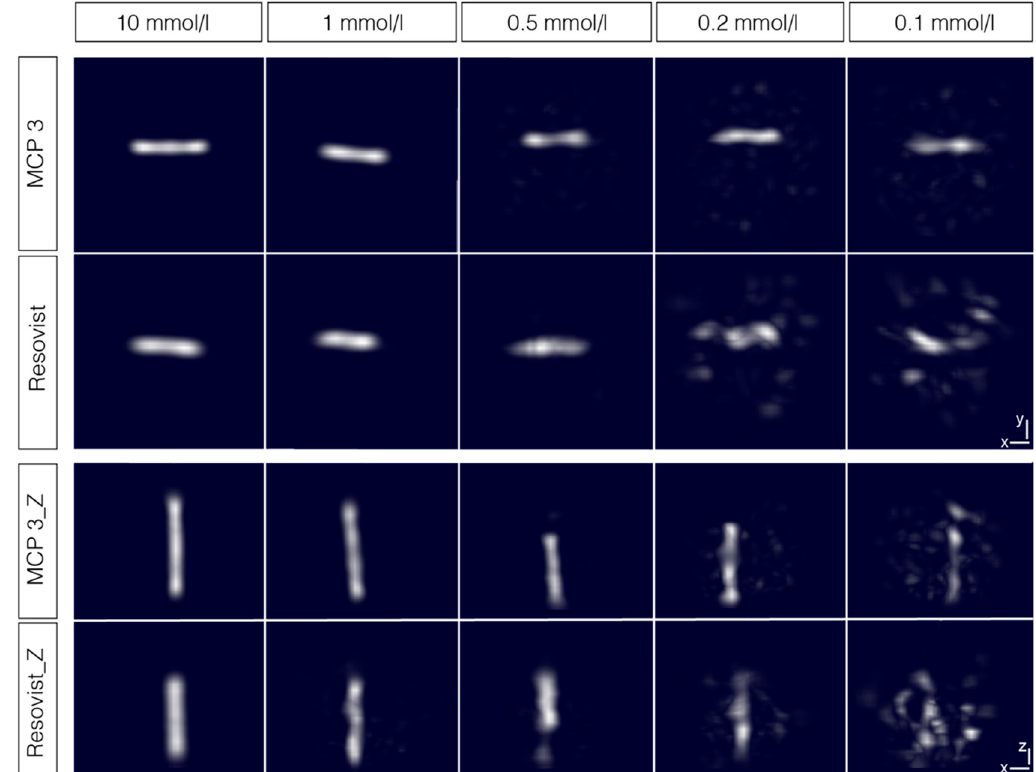
Figure 8. Reconstructed images of the phantom dilution series. PVC tubes with an inner diameter of 3 mm and filled with MCP 3 and Resovist ® at concentrations from 10 to 0.1 mM Fe. The tubes were measured in two orientations to take the different gradients of the selection field into account. Images are interpolated and represented as maximum intensity projections with the threshold set at 50%. For images of phantoms filled with 2 and 5 mmol Fe/l, please see supplement Figure S7.